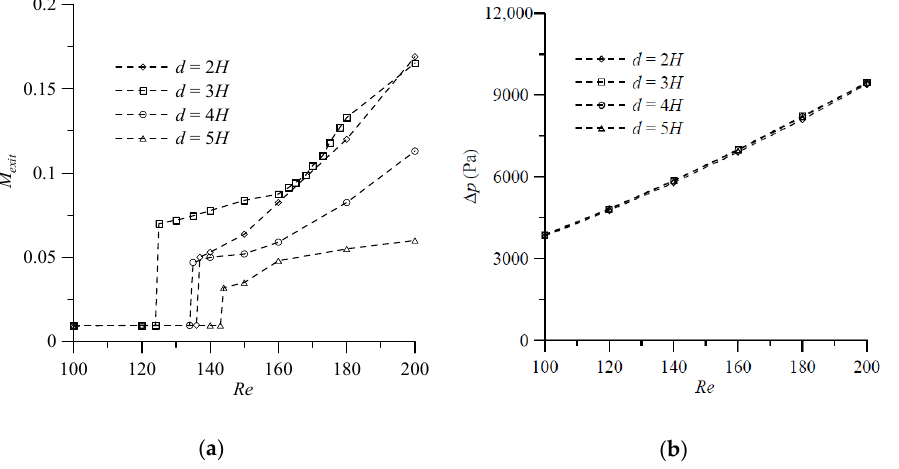
Figure8. yz -projectionofthevelocityvectorsonthecross-sectionsat( a ) x = H ,( b ) x = − H ,( c ) xz -projection of the velocity vectors on the cross-sections at y = H for the case with Re = 80, θ a = 30 ◦ , h = 0.75 H , t = 0.25 H and w d = 0.25 H .